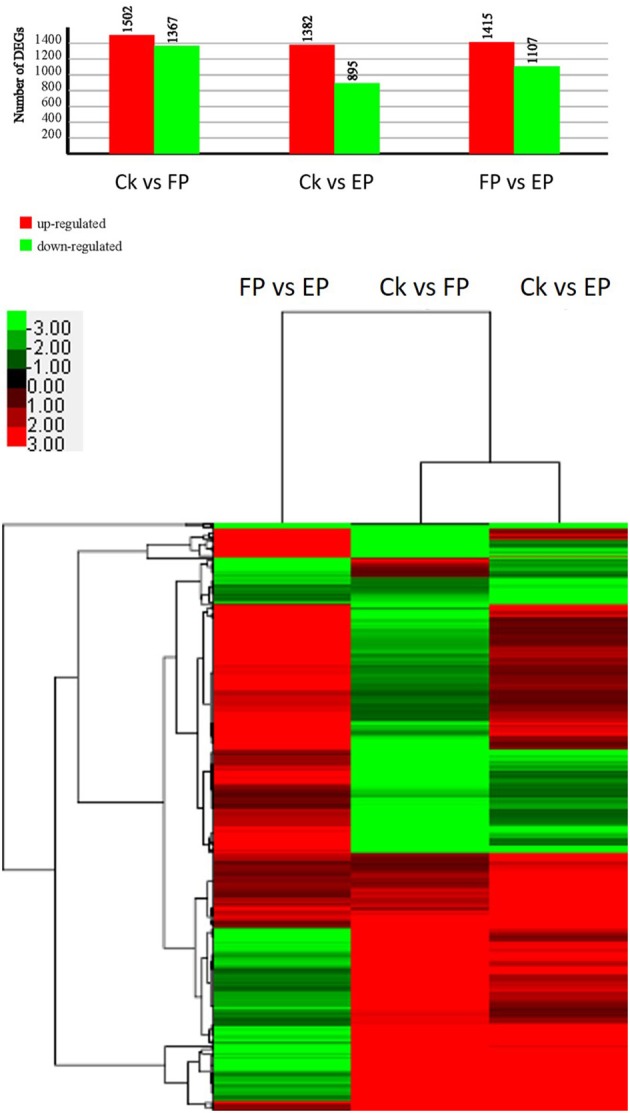
P. liquidambari DEGs induced under various lifestyles. Image above, histogram displaying numbers of DEGs for various lifestyles. Image below, clustering of co-expressed genes among three expression patterns; green to red represent gene expression levels.